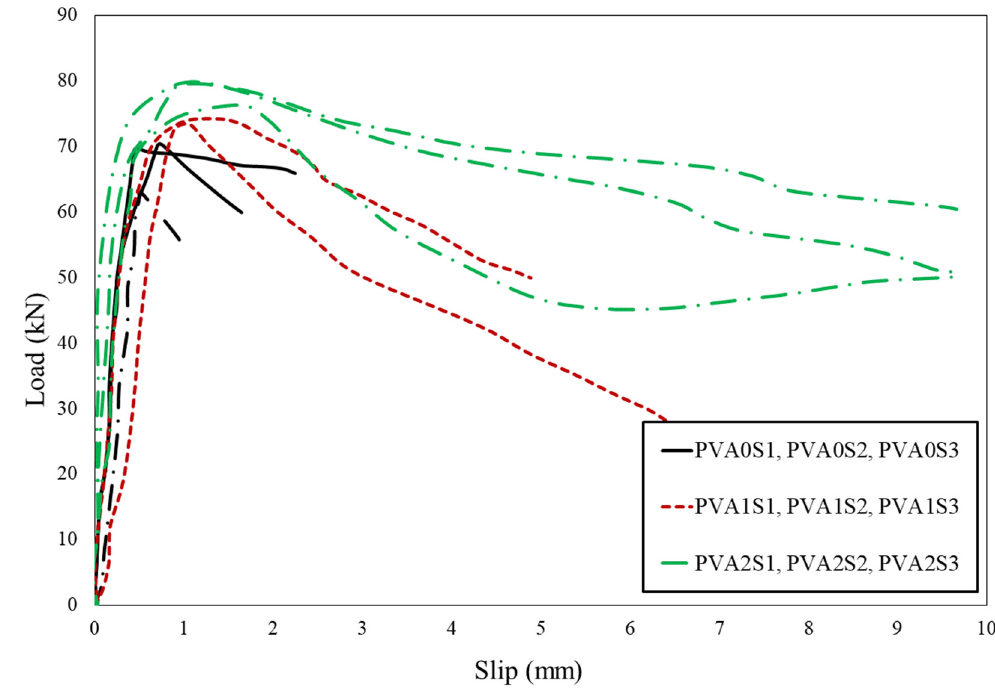
Figure 4. Load–slip curves of uncoated rebars with PVA fiber [32].